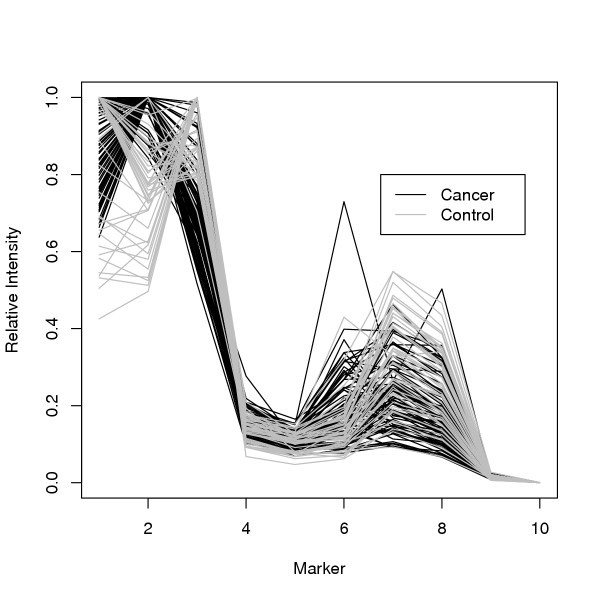
Test set classification of DS1 via 10 markers